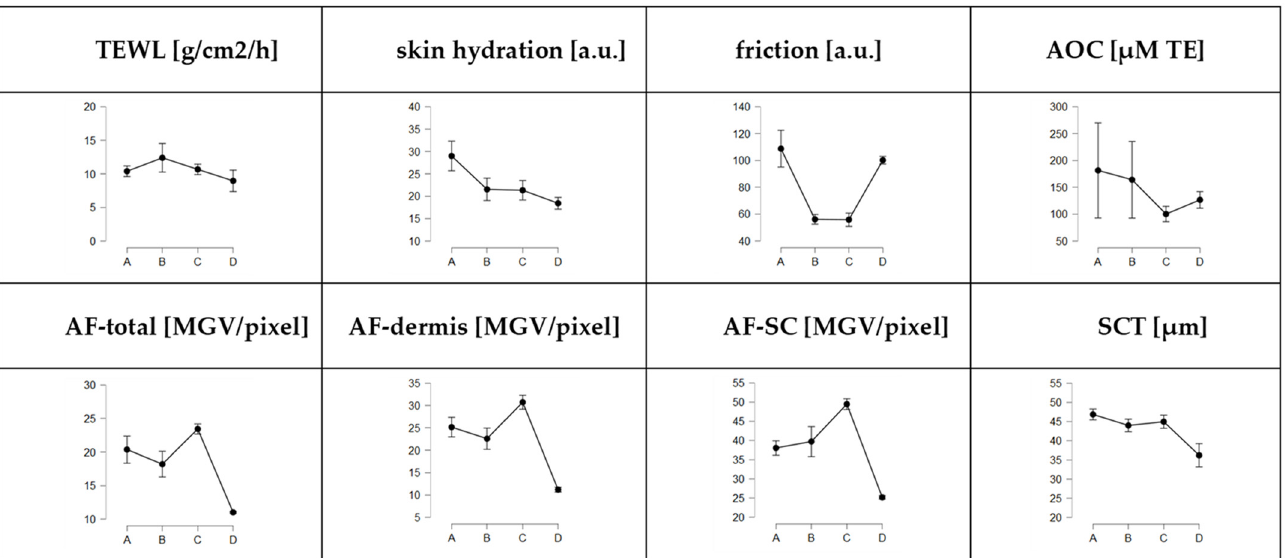
Figure 4. Influence of porcine ear age on penetration efficacy for the six different formulations tested (cf. Table 2). ( A ) = fresh ears, ( B ) = ears stored for 24–36 h, ( C ) = ears stored for 48–60 h, ( D ) = frozen and on-demand defrosted ears. Black dots represent data with outliers included. White dots represent means after elimination of outliers. Lines between the different post-slaughter ages represent the changes in penetration efficacy based on the storage time of the ears.